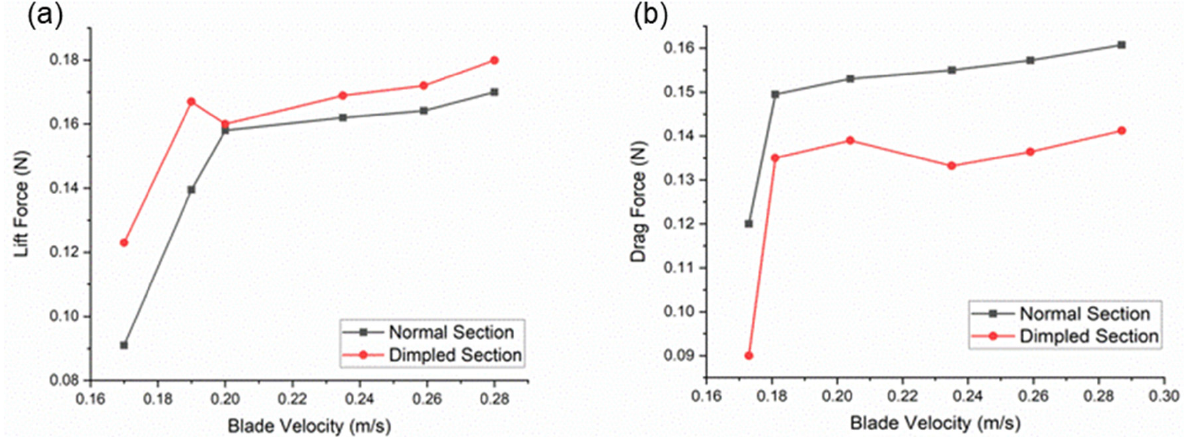
Figure 14. Variation of ( a ) lift and ( b ) drag force due to blade velocity for the MRF case. For the calculation of uncertainty in lift and drag forces, a similar method to that adopted in SRF is used in MRF, as presented in Table 4. For the normal section, the lift coefficient uncertainty is decreased from 12 to 10%, whereas, for the dimpled section, it is decreased from 8.5 to 8.2%. Similarly, for the normal section, the drag coefficient uncertainty remains the same, whereas, for the dimpled section, it is increased from 5 to 5.8%. The results have uncertainty due to the following reasons. Table 4. Uncertainty calculations of both sections of the turbine blade at an optimum AOA for MRF.